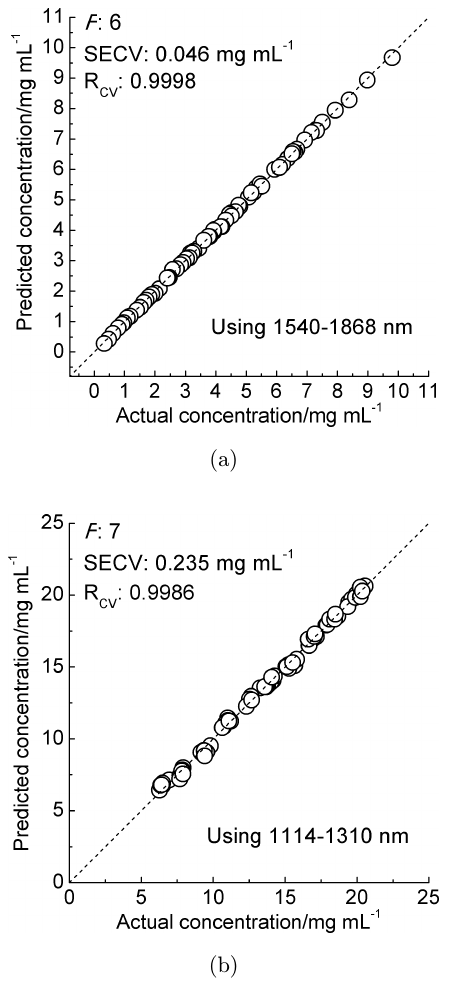
Fig. 11. Relationship between the predicted and actual con- centrations of (a) TCP and (b)